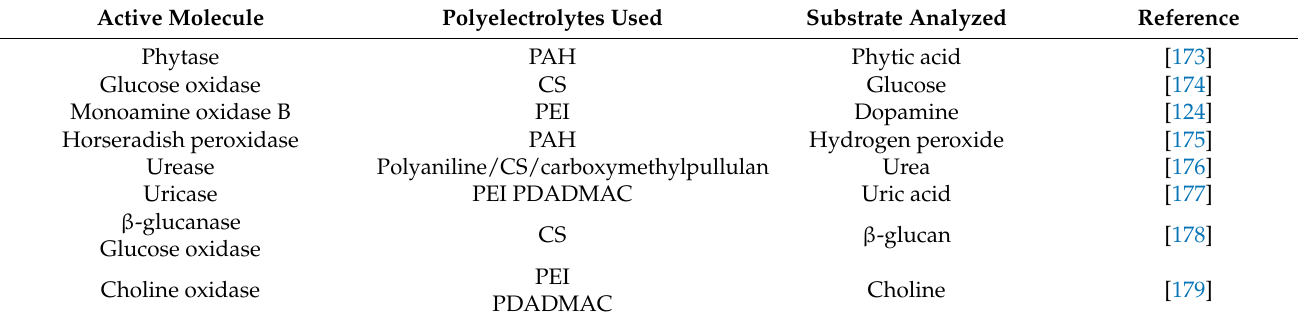
Optical biosensors are based on the interaction of the optical field with a